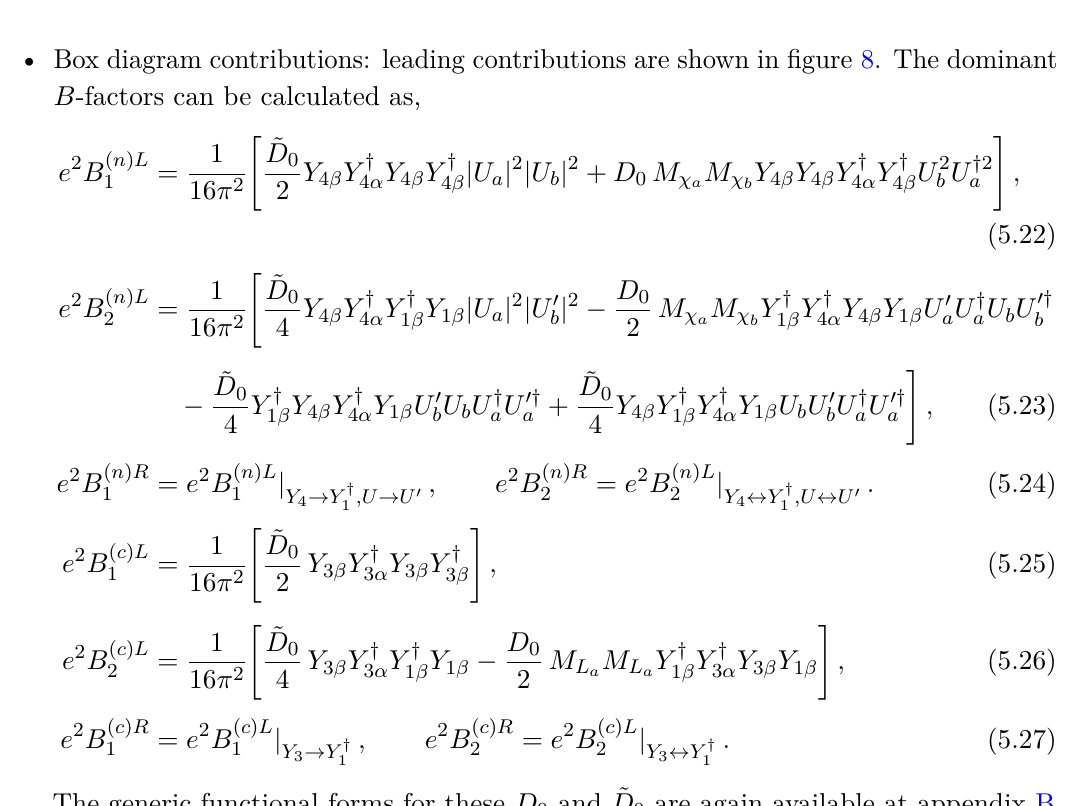
) and s = η 0 , s = S a,b 1 2